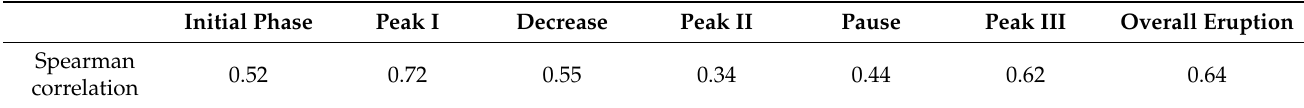
Figure 4. Plot shows the radiant power of the 2021 Fagradalsfjall eruption from MODIS FRP in red and from MODVOLC in light blue. The Spearman correlation coefficient of these two datasets is 0.64 over the entire duration of the eruption. Table 1. Spearman correlation coefficient showing the degree of correlation between MODIS FRP and MODVOLC during the 2021 Fagradalsfjall